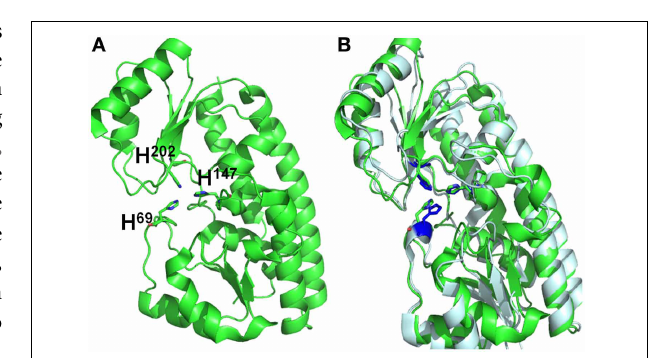
FIGURE 3 | Structural alignments between VPA1307 and ZnuA from Synechocystis sp. (A) VPA1307 modeled structure. Structure of VPA1307 was modeled using SWISS-MODEL program and three conserved histidine residues were labeled. (B) Structural comparison of VPA1307 (green) and the crystal structure of ZnuA from Synechocystis sp. (PDB accession number 1PQ4) template (gray). A TM score of 0.97 was obtained over 252 aligned